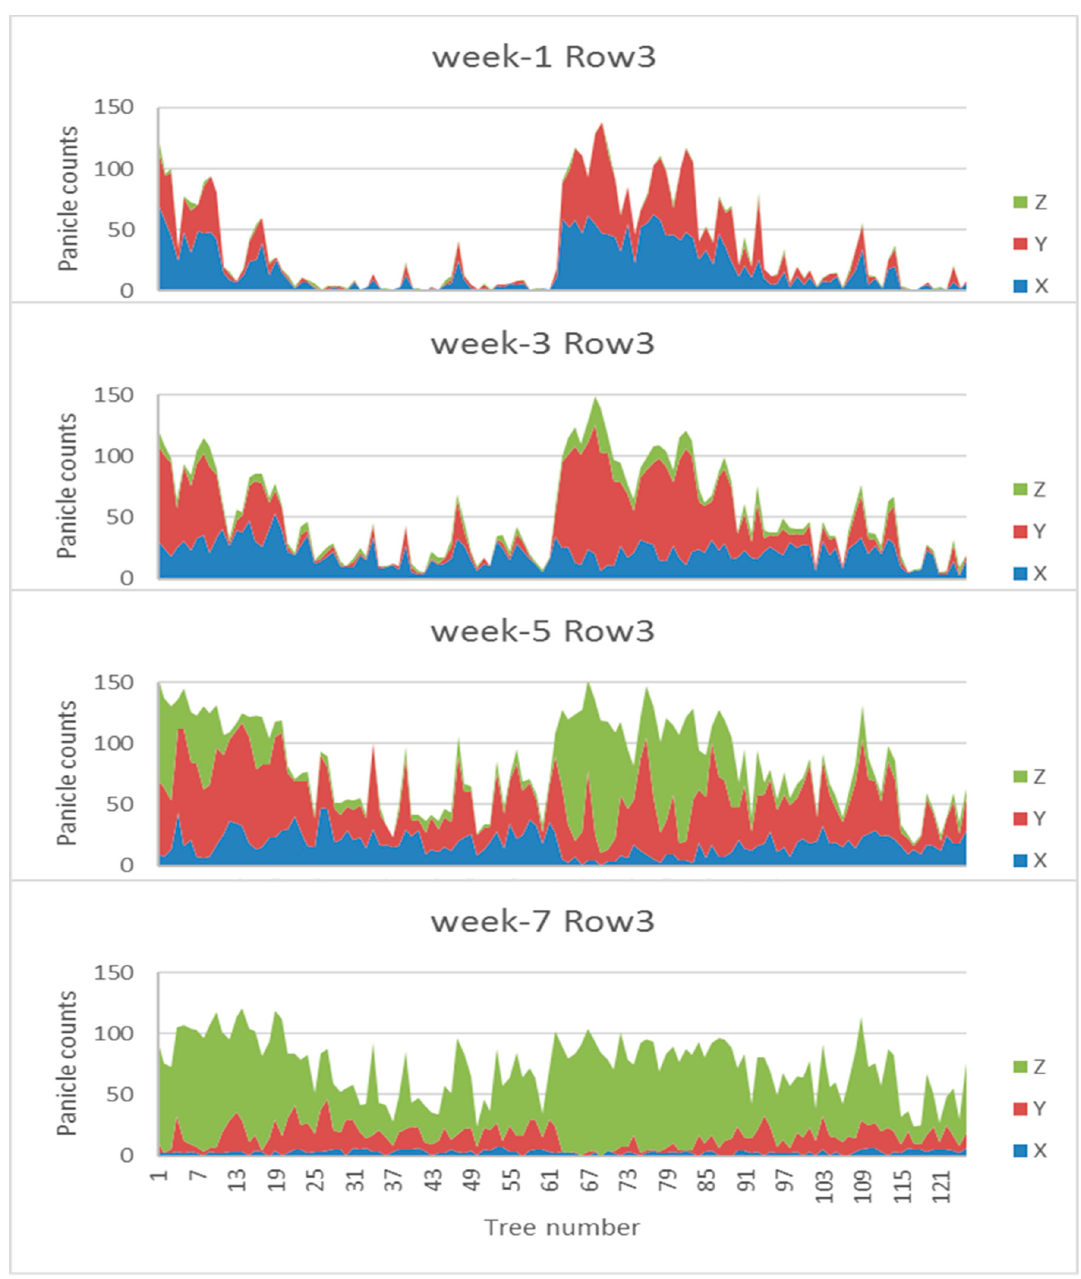
Figure 9. Course (weeks 1, 3, 5 and 7) of panicle number by developmental stage per tree for a row of trees.